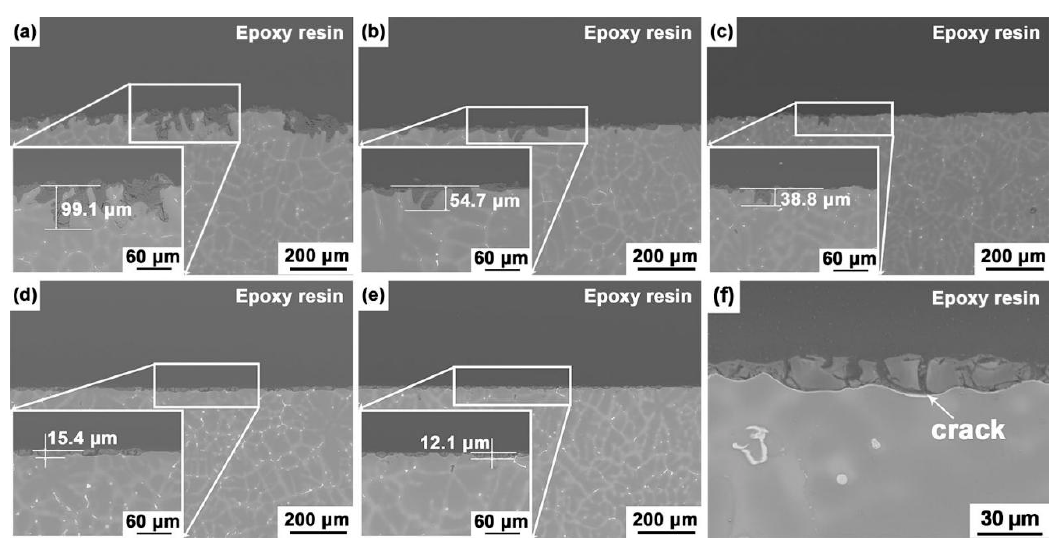
Figure 10. Cross-section morphologies of the Mg–5Sn– x Ga alloys after immersion in 3.5 wt % NaCl solution for 72 h: ( a ) Mg–5Sn, ( b ) Mg–5Sn–0.5Ga, ( c ) Mg–5Sn–1Ga, ( d ) Mg–5Sn–2Ga, ( e ) Mg–5Sn–3Ga; the inserts are high-magnification scanning electron microscope (SEM) micrographs of the alloys; ( f ) a typical SEM micrograph showing the cracks on the surface of the Mg–5Sn–3Ga